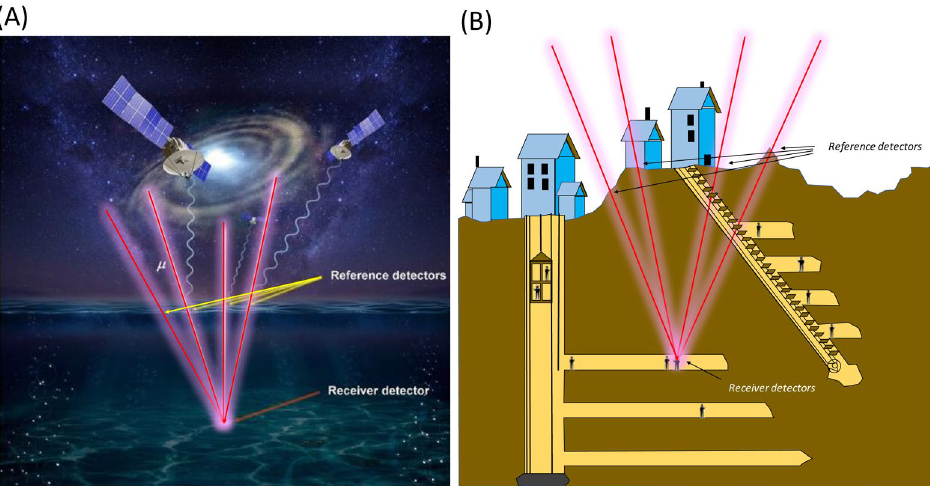
Figure 1. Principle of muPS. For underwater navigation, multiple reference detectors are located on the sea surface to navigate underwater receivers ( A ), and for underground navigation, multiple reference detectors are located on the ground surface to navigate underground receiver ( B ). The red lines indicate the muon trajectories. The copyright for these images is owned by